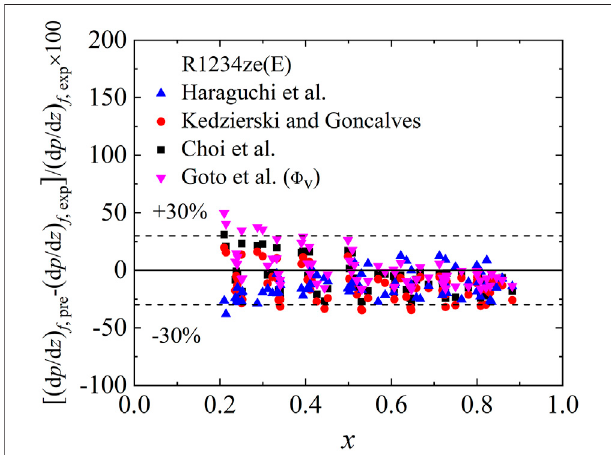
FIGURE 12 | Comparison of predicted and experimental friction pressure